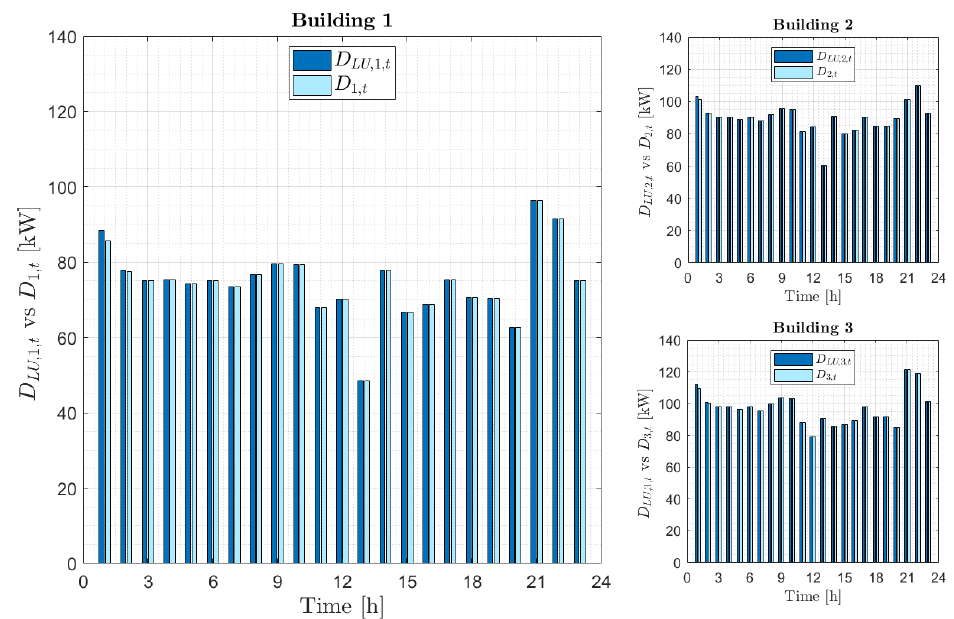
Figure 10. Power exchange between the nodes and the LUs (buildings) compared with their reference values.